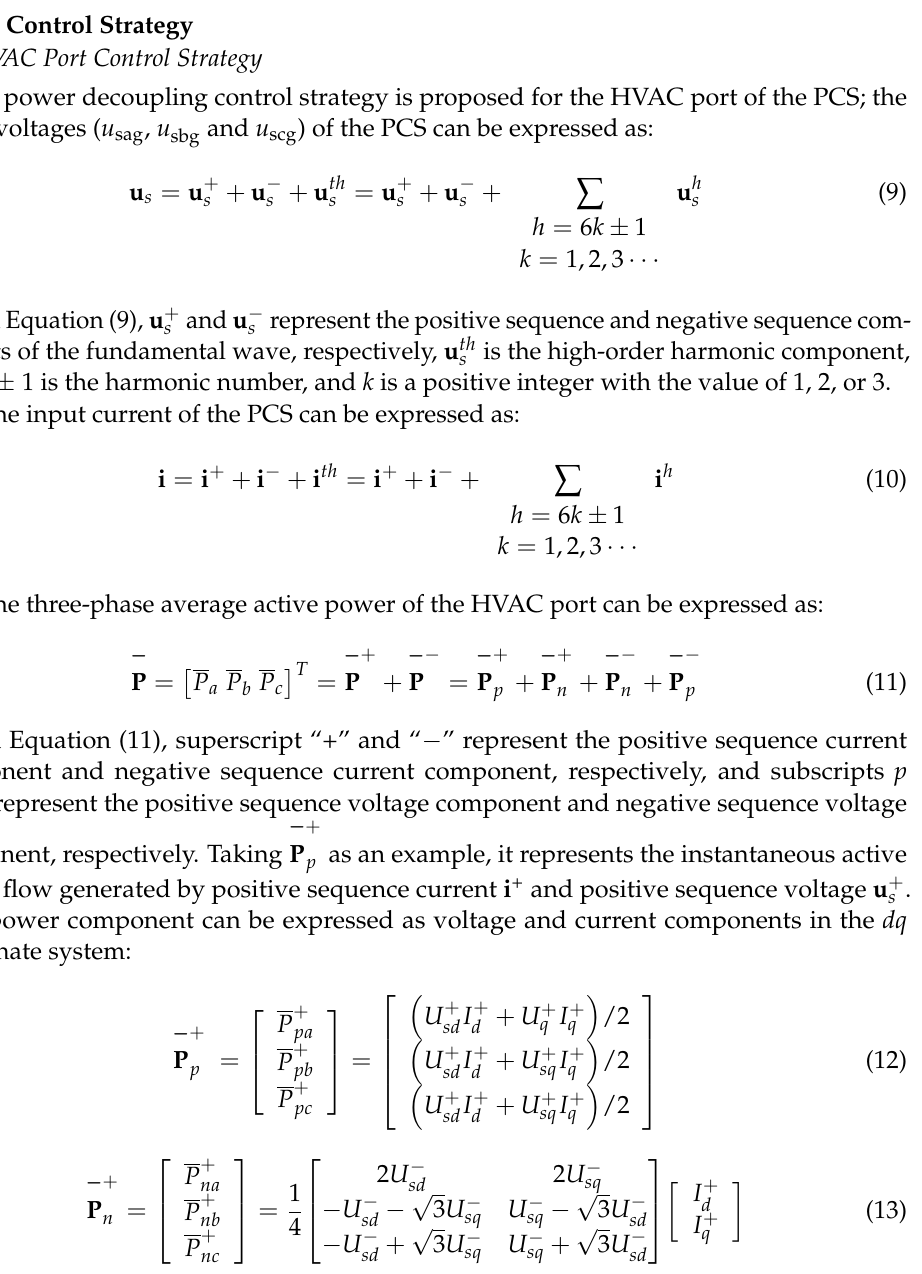
Figure 4. Relationship between transmission power and phase-shift angle.